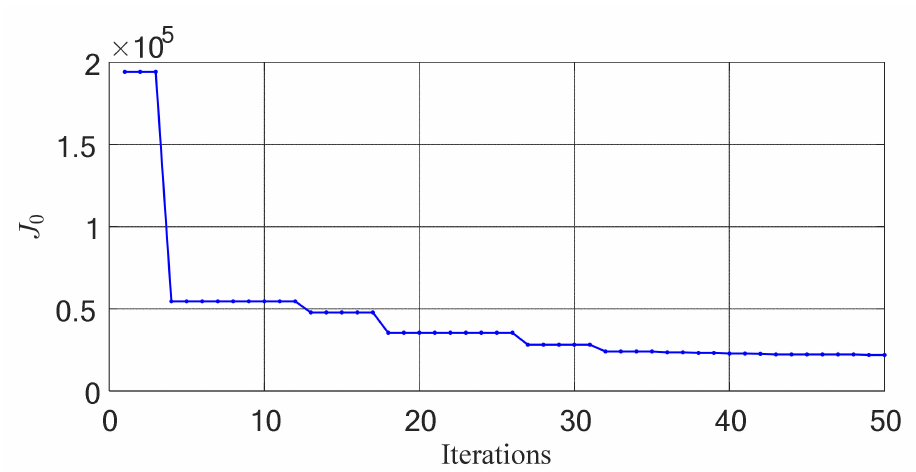
Figure 4. Convergence graph of performance index J 0 when the simplex method based on the initial vertices given in Table 2 is used to search for the controller parameters of the inverted pendulum system.